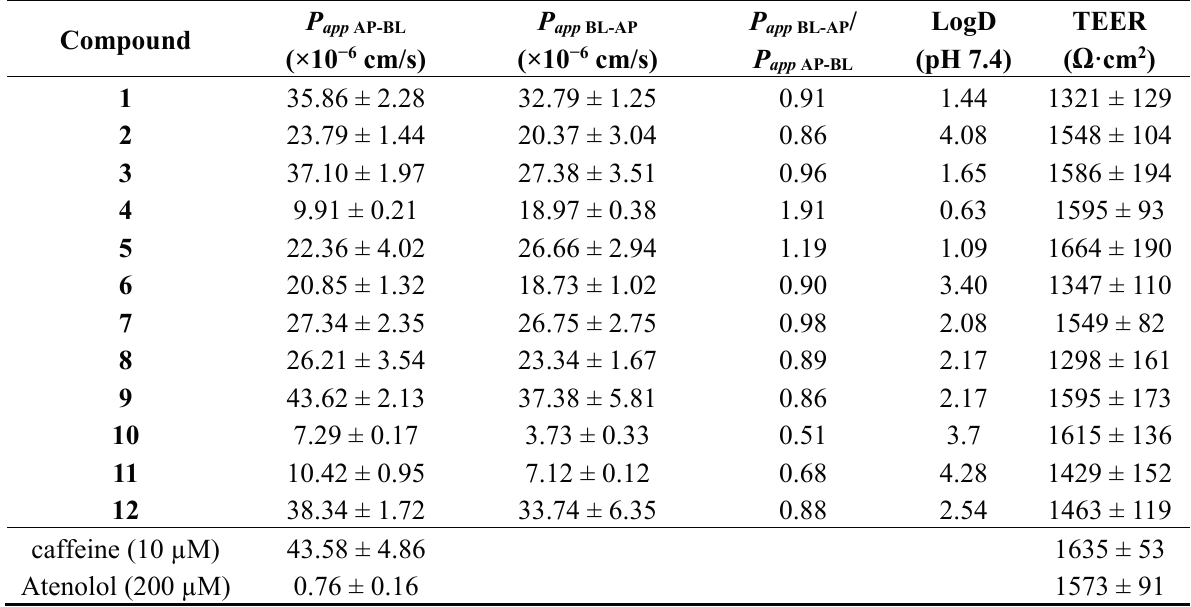
Table 1. The bidirectional P app values of twelve coumarins in the MDCK-pHaMDR cell monolayer.